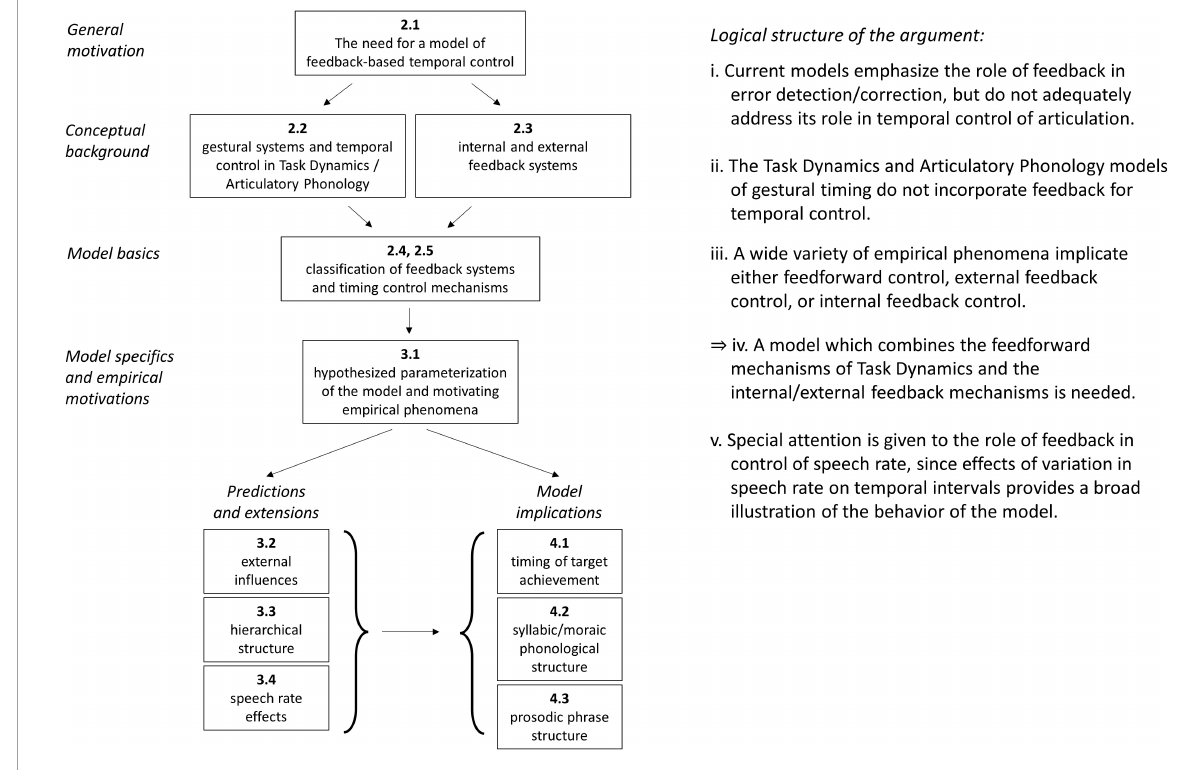
FIGURE1 Graphical illustration of manuscript organization and propositions comprising the main argument.